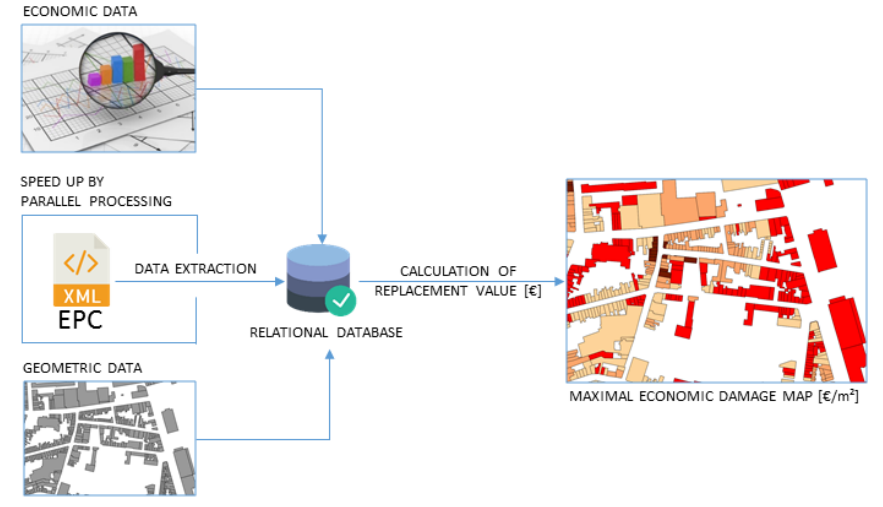
Figure 3. Code segment of the Energy Performance Certificates (EPC) extraction script.